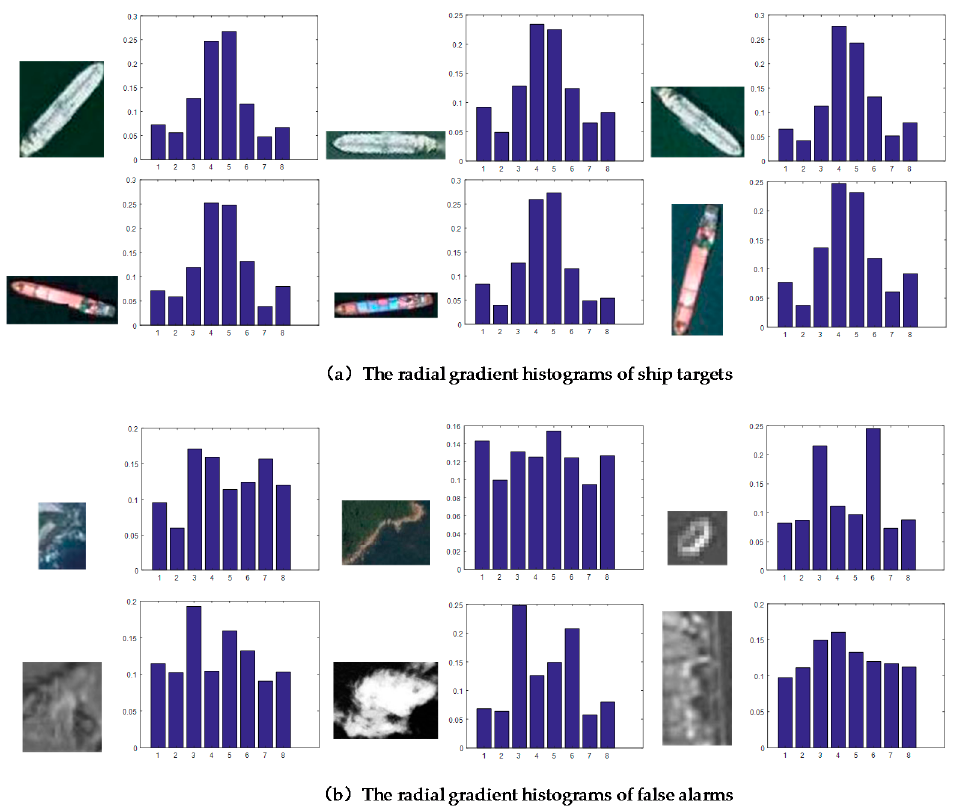
Figure 7. Radial gradient histogram statistics of the ship candidates. The x-coordinate denotes the eight orientation bins and the y-coordinate denotes the radial gradient statistic information in the gradient histogram. Ships with different orientations, sizes and textures share similar histogram distribution which is different from that of false alarms.